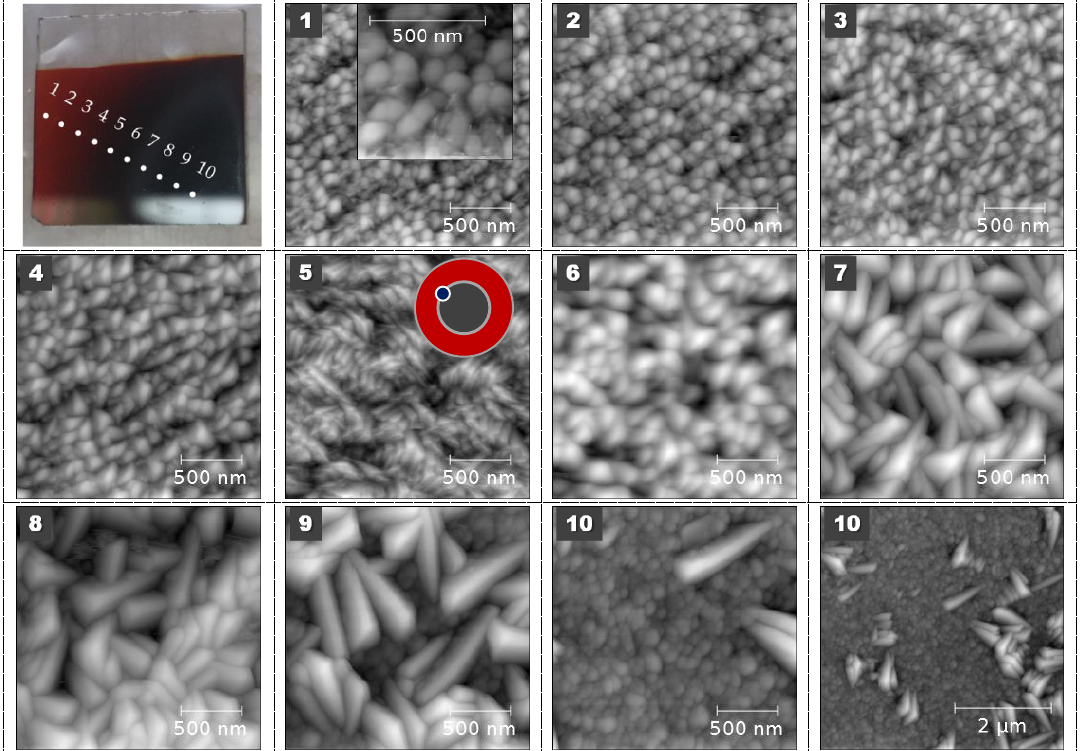
Figure 6. AFM images of iron oxide nanocrystals measured at different positions 1 to 10 marked on a thin film photograph (top left). Image at position 10 shown with two different magnifications. Film was deposited on a glass substrate in DC mode at discharge current 300 mA, voltage 296 V, pressure 4.6 Pa, distance from the nozzle 4 cm, argon flow rate 170 sccm and oxygen flow rate 1 sccm. The films were also analyzed by an SEM microscope equipped with a focused ion beam. A small platinum mask was deposited on top of the film. The ion beam then created the sharp cross-section below the mask edge (see Figure 7). The morphology of the film surface with pyramidal crystal